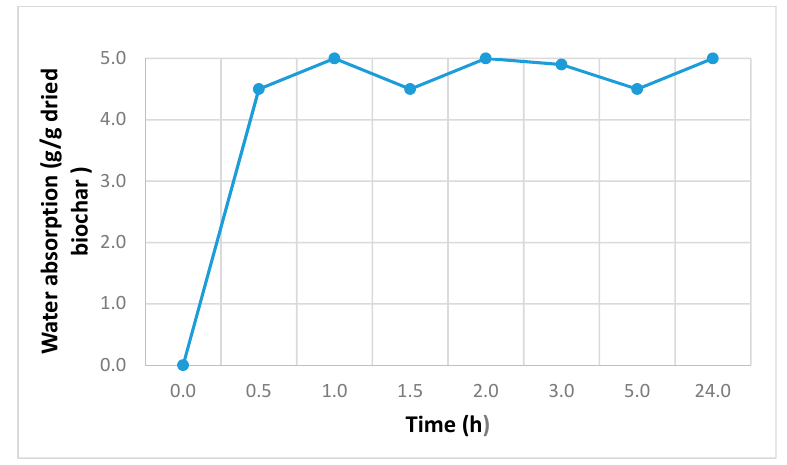
Figure 5. Water absorption trend of